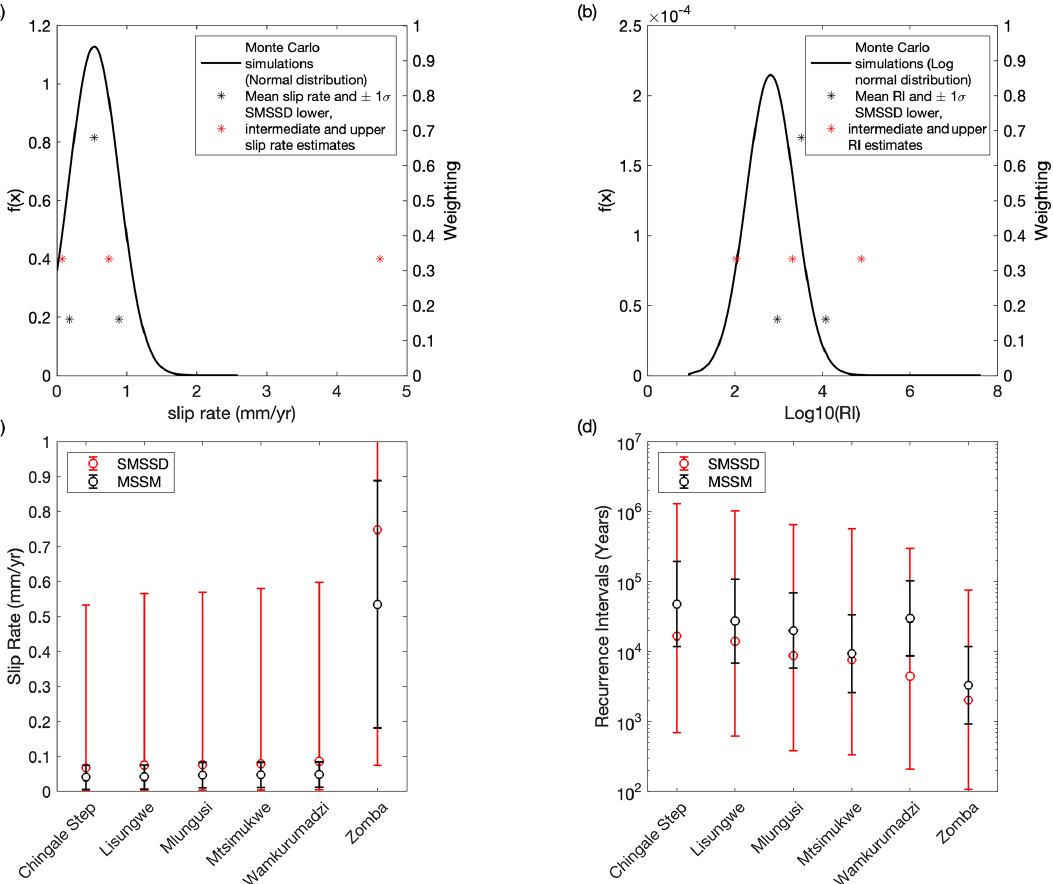
Figure 7. Comparison of uncertainty between the Malawi Seismogenic Source Model (MSSM) and the South Malawi Seismogenic Source Database (SMSSD; Williams et al., 2021a). (a) Slip rate for the Zomba fault modelled from the extreme cases of the logic tree (SMSSD) and from 10000 Monte Carlo simulations through the logic tree (Fig. 6) and then fit to a normal distribution truncated at zero (MSSM). For the MSSM, results can also be discretized by the mean value ± 1standard deviation ( σ ). For the SMSSD, no weighting was formally assigned to either estimate and so is depicted here as three equal weightings. (b) Equivalent to panel (a) but for the Zomba fault recurrence interval ( R ), which follows a log normal distribution. Comparison of (c) mean slip rate and (d) mean recurrence interval estimates for all faults in the Zomba Graben between the SMSSD and MSSM is shown. Error bars represent extreme values (SMSSD) and 1 σ